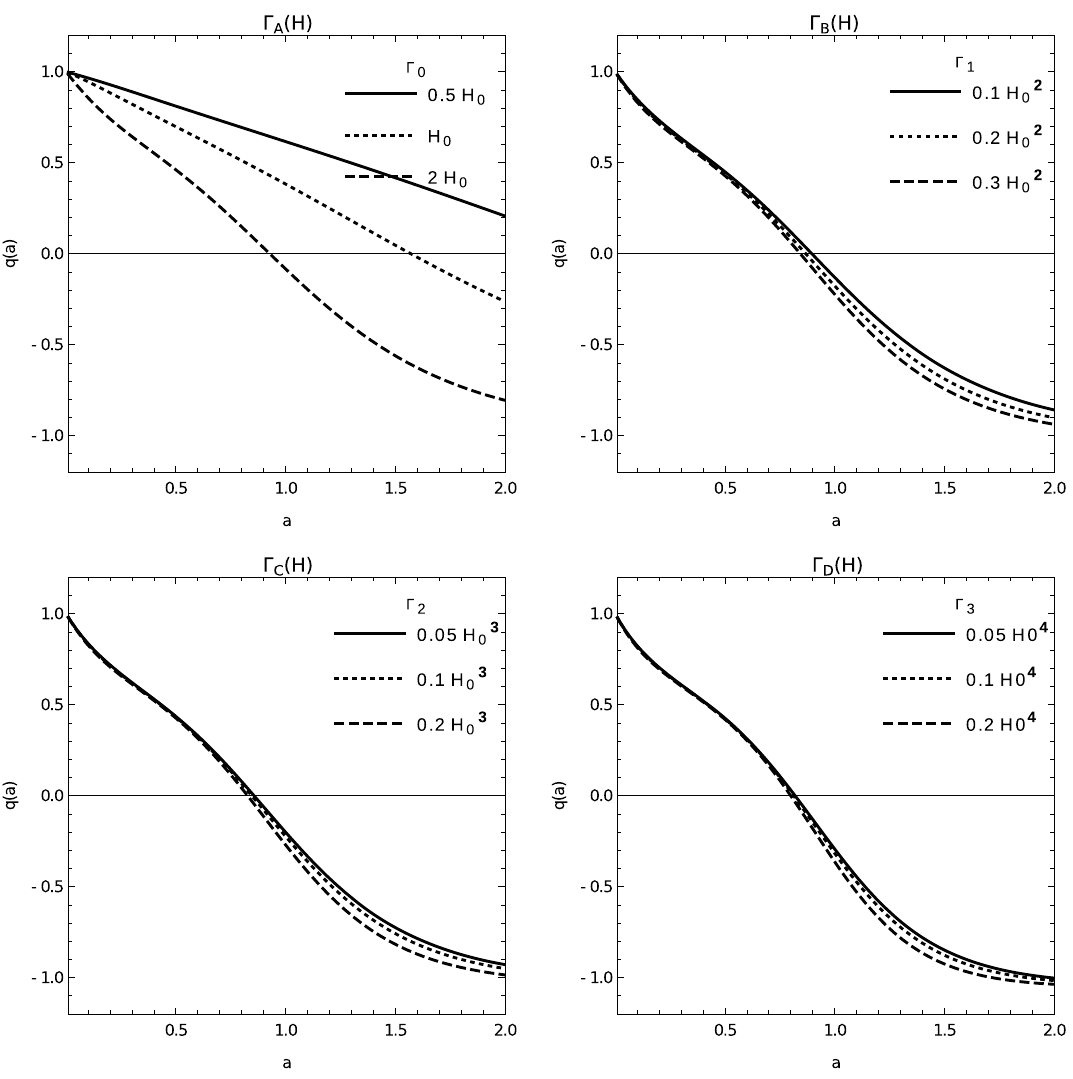
Fig. 2 Qualitative evolution of the deceleration parameter q ( a ) given by numerical solutions of the master Eq. (9) for various particle cre- ation models as given by the expression ( 11). The upper left panel stands for (cid:2) A ( H ) = (cid:2) 0 where (cid:2) 0 = 0 . 5 H 0 (solid curve), H 0 (dashed curve)and2 H 0 (longdashedcurve).Theupperrightpanelfor (cid:2) B ( H ) = 2 H 0 + (cid:2) 1 H − 1 with (cid:2) 1 = 0 . 1 H 2 0 . 3 H 2 (longdashed curve). The lower left panel stands for (cid:2) C ( H ) = 0